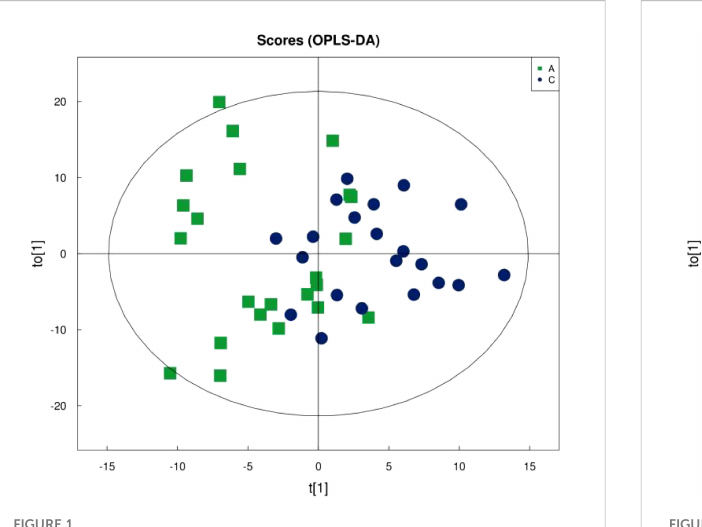
FIGURE 3 OPLS-DA score plot for placebo vs. normal young adults.